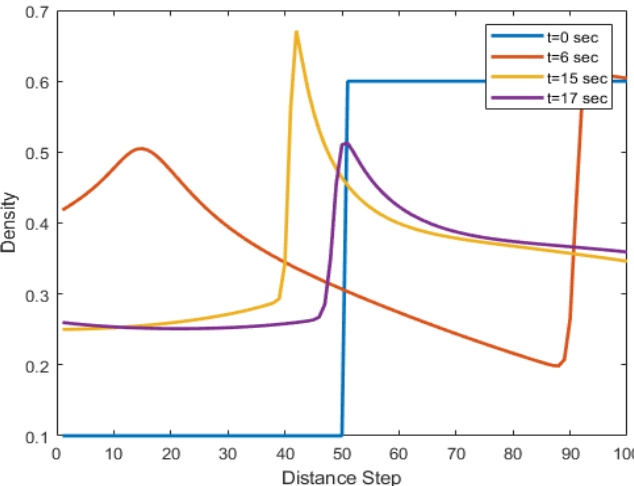
Figure 5. Density behavior of proposed model on straight road with ingress traffic.